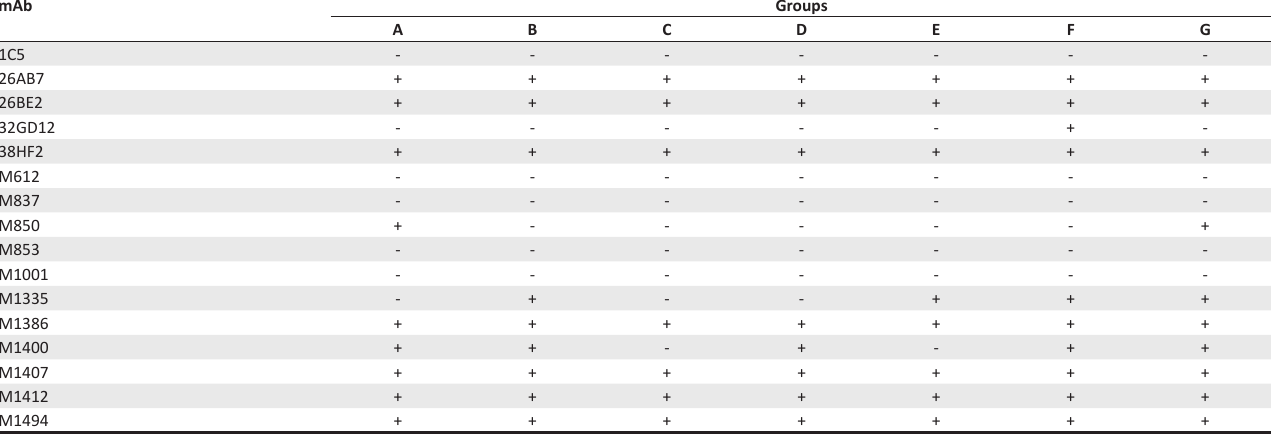
TABLE 5: Indirect immunofluorescence assay reactivity patterns obtained for mongoose rabies viruses.